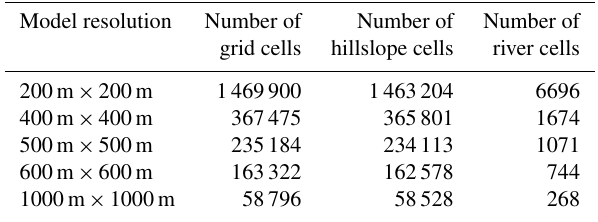
Table 5. Grid cell numbers with different model spatial resolution. Model